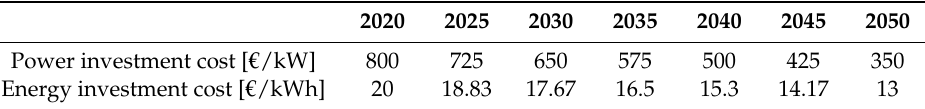
Table 6. Projected investment cost for pumped thermal energy storage